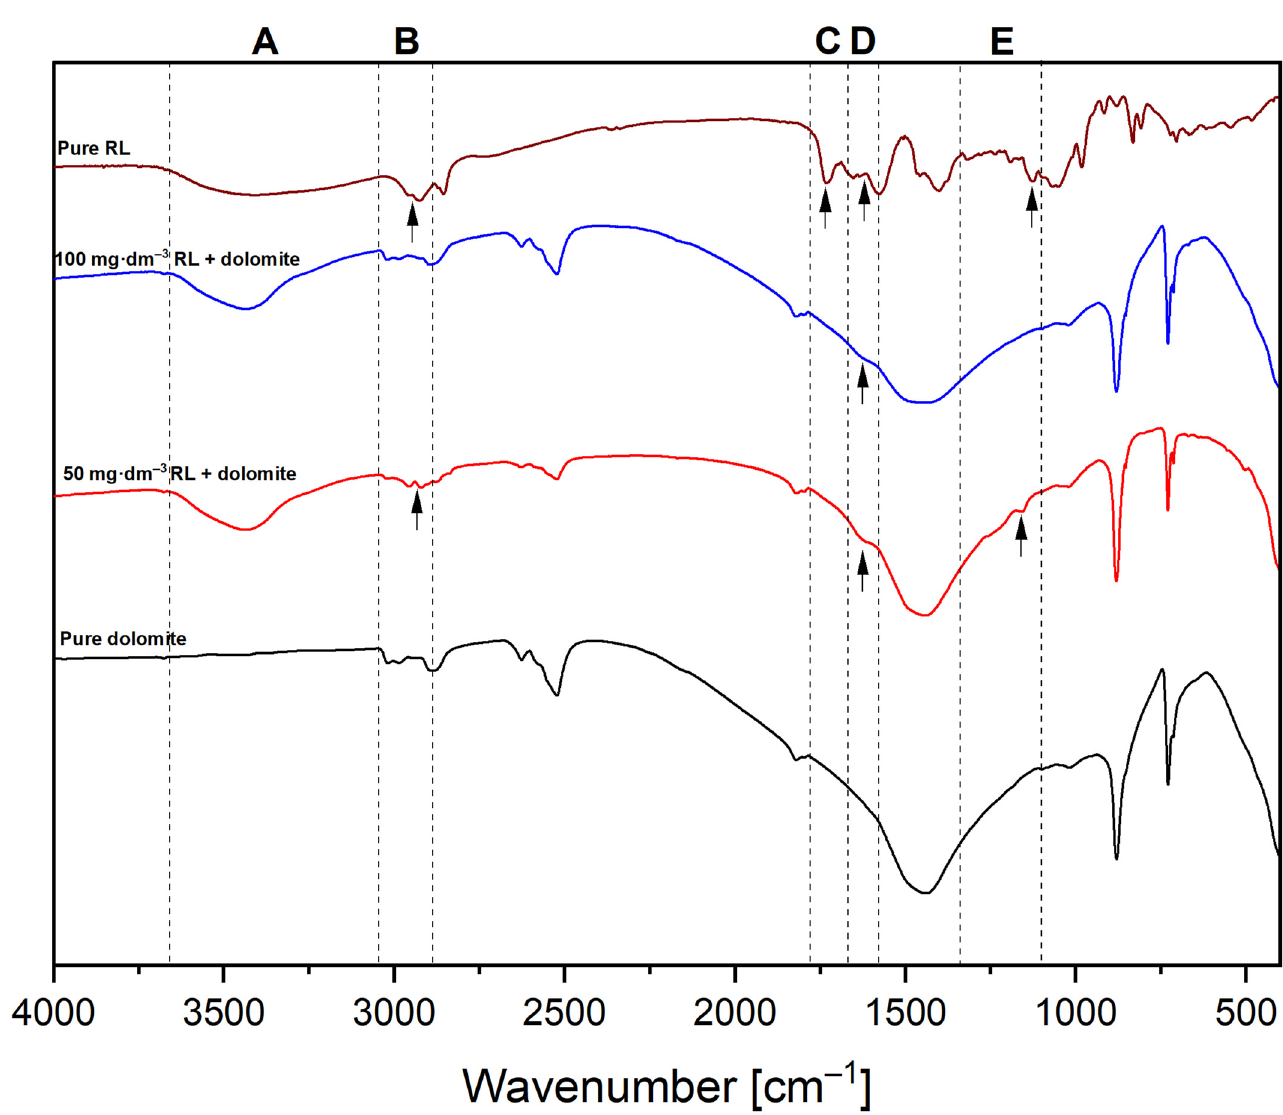
Figure 3. FT-IR spectra of pure RL, dolomite, and sediment obtained after contact with aqueous solutions of RL of concentrations of 50 and 100 mg · dm − 3 . ( A – E ) Identified regions used to describe the RL adsorption process on the dolomite